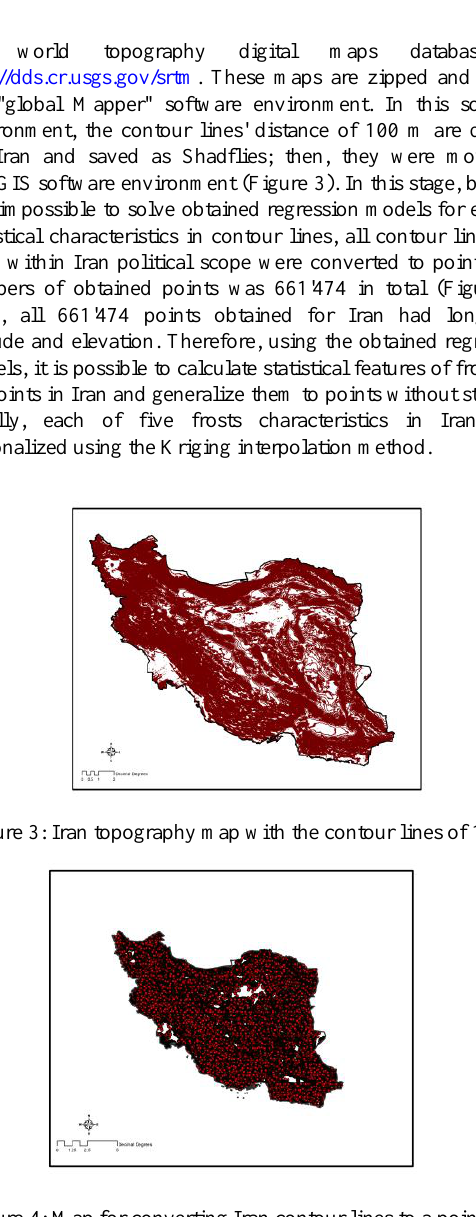
Figure 4: Map for converting Iran contour lines to a point map (the number of points is 661'474)